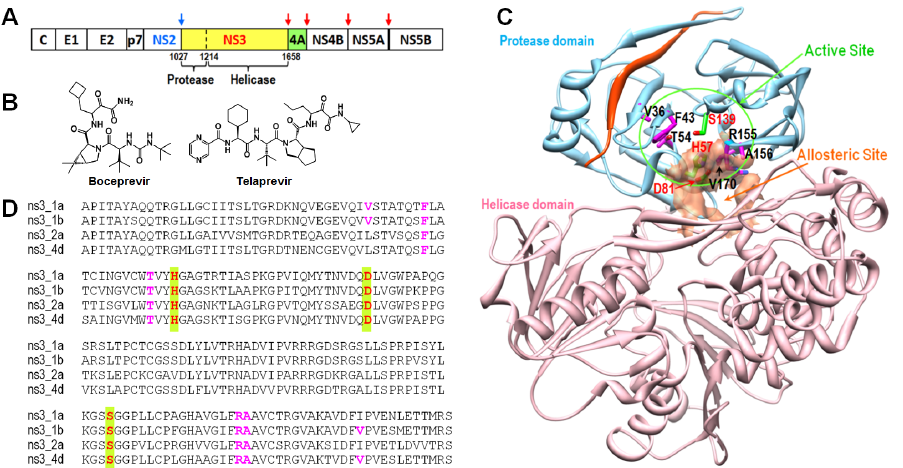
Figure 1. Background information and sequence alignment. ( A ) Schematic of the HCV polyprotein with cleavage sites of the two proteases, NS2 and NS3. ( B ) Structures of two FDA-approved NS3/4A inhibitors. ( C ) Structure of the NS3/4A serine protease, with the NS3 protease domain colored in cyan, and the co-factor NS4A (beta strand) shown in red. The active site residues, S139, H57 and D81, sit on the protein-protein interaction surface and are shown as stick figures in green. The amino acids prone to mutation in the binding site enabling drug resistance against both Telaprevir and Boceprevir are shown as stick figures in magenta (V36, F43, T54, R155 and A156). Images were prepared using Chimera v1.6.1, UCSF, 2012 [37]. ( D ) Sequence alignment of NS3 proteases from four HCV genotypes. NS3 from genotypes 1a, 2a, and 4d are 90%, 69%, and 82%, respectively, as compared to the NS3 from genotype 1b ( Figure 1D ). The response rate of patients infected with genotype 1 (1a and 1b) to the current PEG-INTRON plus ribavirin standard therapy is only 40–50% while that of patients infected with genotypes 2 and 3 is approximately 80% [18,19].